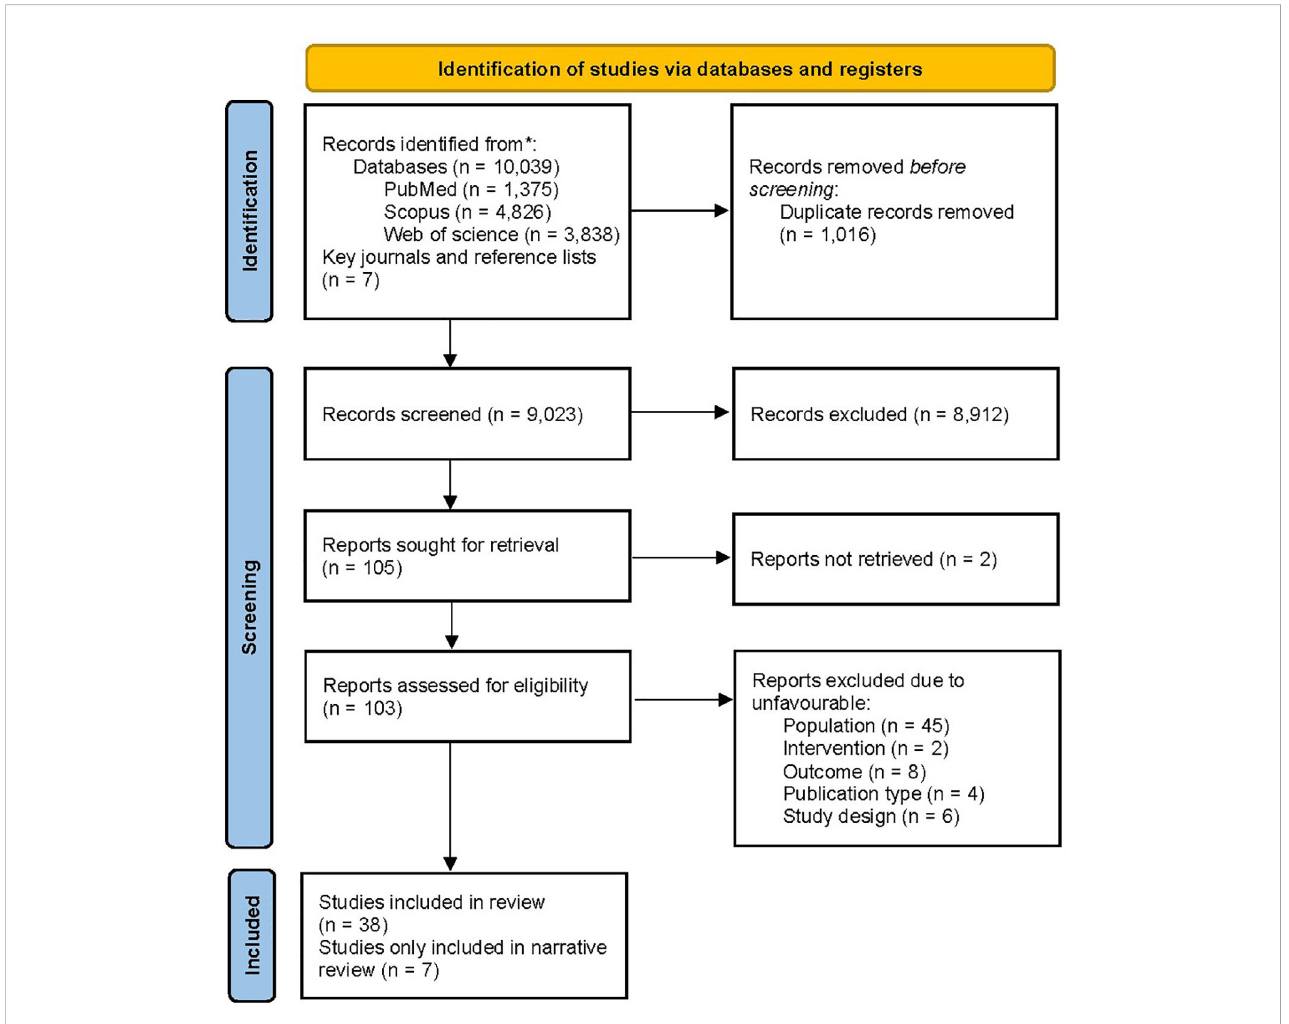
FIGURE 1 PRISMA fl ow chart of the literature screening. PRISMA, Preferred Reporting Items for Systematic Reviews and